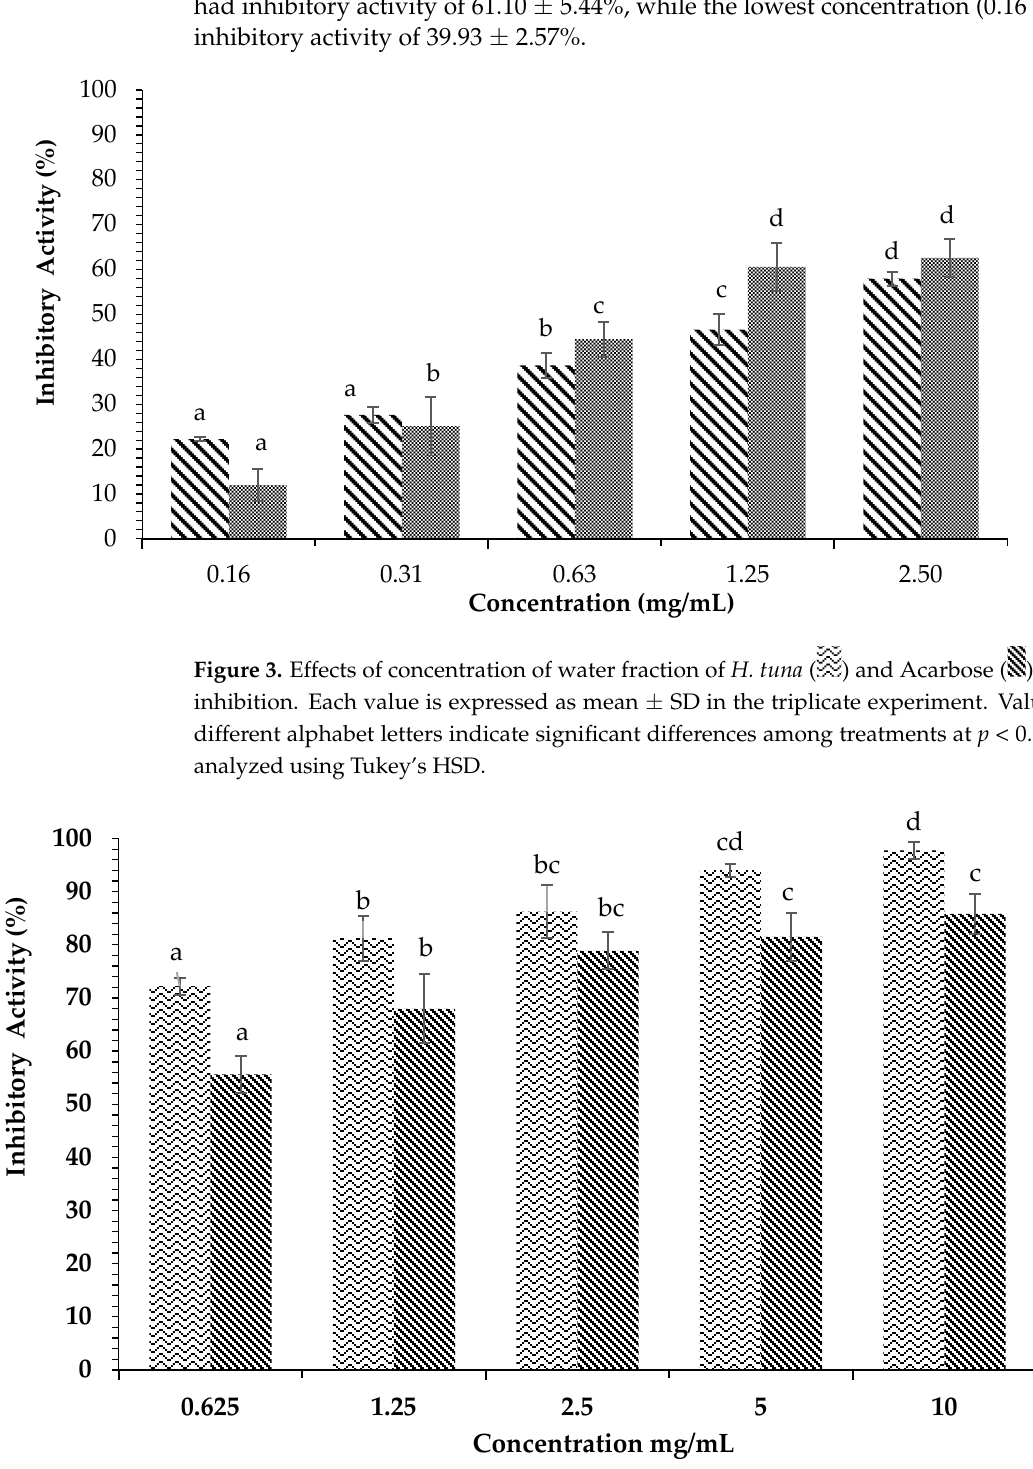
Table 1. Inhibitory activity (IC 50 ) of H. tuna methanol extract, ethyl acetate fraction, water fraction, and acarbose against α -amylase and α -glucosidase. Figure 4. Effects of concentration of methanol extract of H. tuna ( ) and Acarbose ( ) on α -glucosidase inhibition. Each value is expressed as mean ± SD in the triplicate experiment. Values (a–d) with different alphabet letters indicate significant differences among treatments at p < 0.05, which was analyzed using Tukey’s HSD.